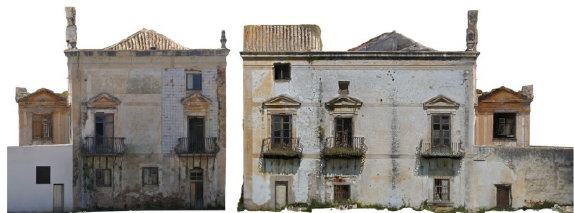
Figure 17. North-east and south-west façades ortho-images.